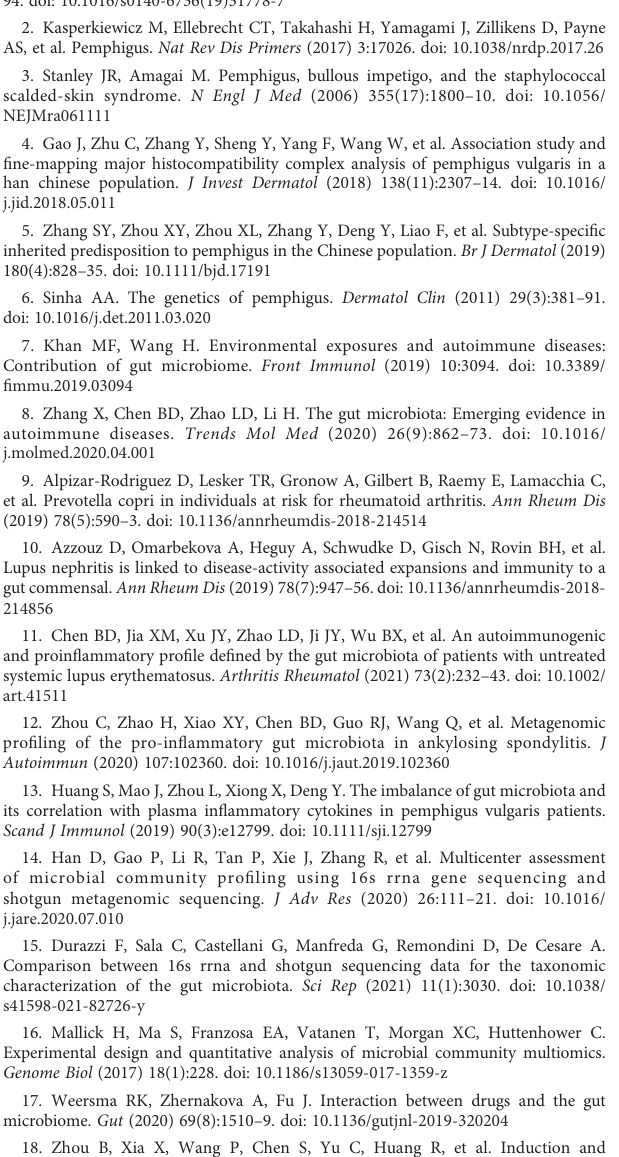
groups; (D, F) Differential genus between the healthy control and PV groups; (G) Contribution of each species to the random forest model in the optimal set. PV, pemphigus vulgaris; DMM, Dirichlet Multinomial Mixture Model. SUPPLEMENTARY FIGURE 2 Subgroup analysis speci fi cally with PV and their matched family member controls. (A) The a -diversity(left)and b -diversity(right)ofthegutmicrobiome in the PV patients and their matched family members; (B) Results of differential bacteria between PV and family members by LEFse analysis; (C) Main differential species between PV patients and their family members (* represents statistical signi fi cance with the P value <0.05 using Wilcoxon sum- ranktest); (D) C-leveldifferenceKEGGpathwaybetweenPVpatientsandtheir matched family members, horizontal coordinate represents the P value of -log10. PV, pemphigus vulgaris; PCoA, principal coordinates analysis; LEFse,